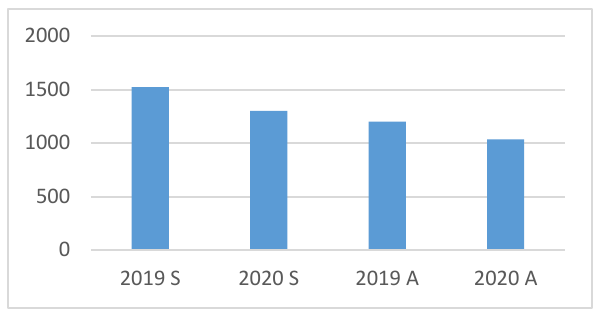
Figure 5. Bronchoalveolar lavage fluid cultures. Table 5. Bronchoalveolar lavage fluid cultures.